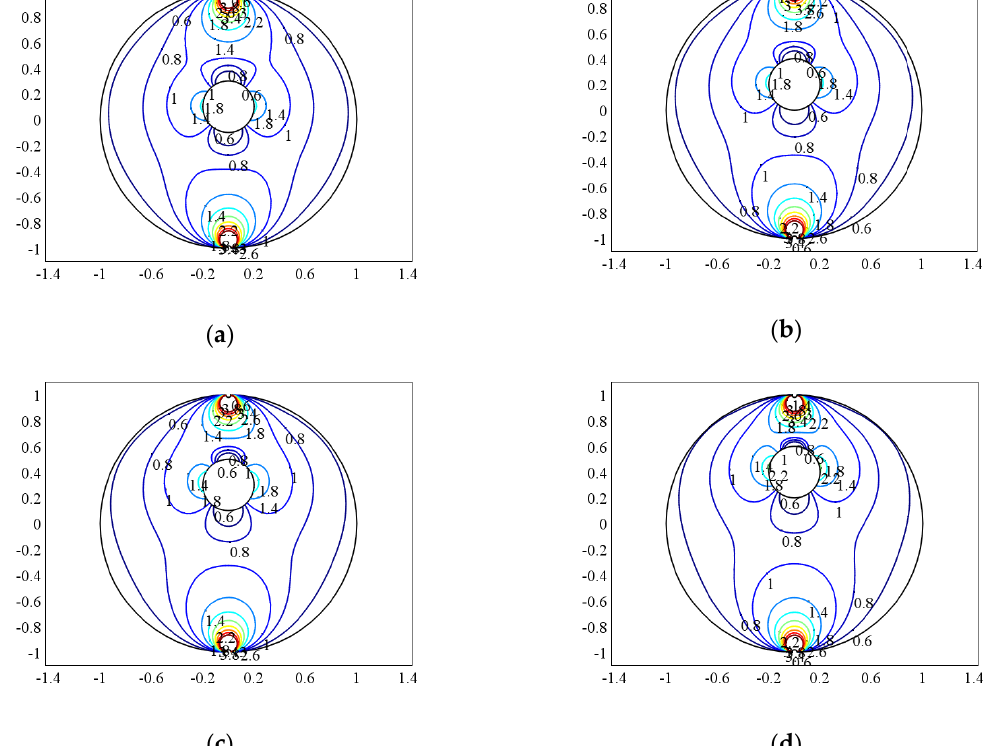
Figure 5. The weight function distribution at b = 0. ( a ) e = 0.1, ( b ) e = 0.2, ( c ) e = 0.3, ( d ) e = 0.4.